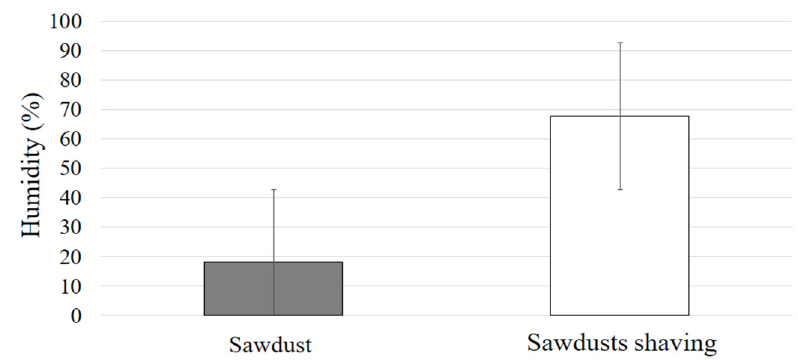
Figure 5. Humidity content of the samples.